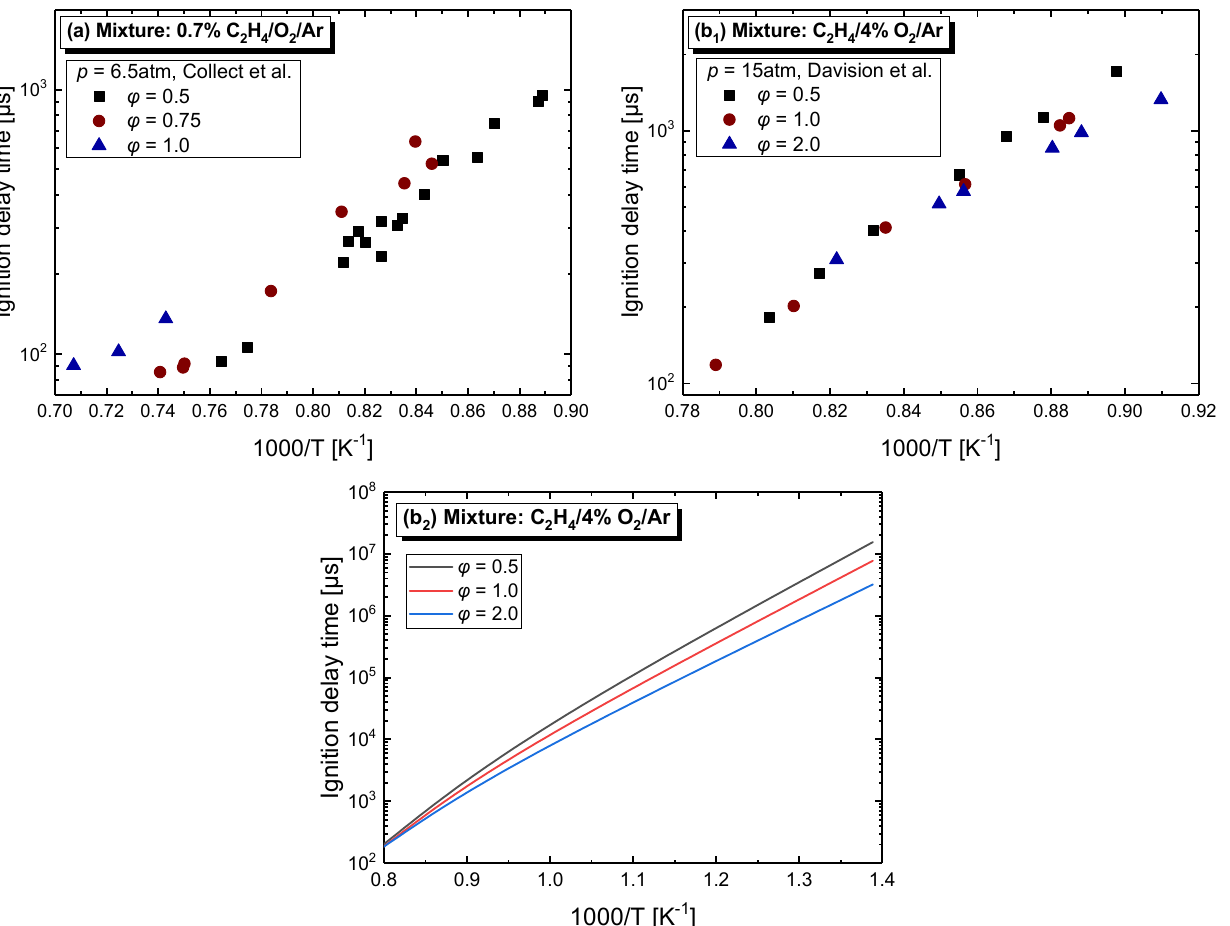
Figure 13. Equivalence ration dependence of ethylene IDTs. ( a ) case